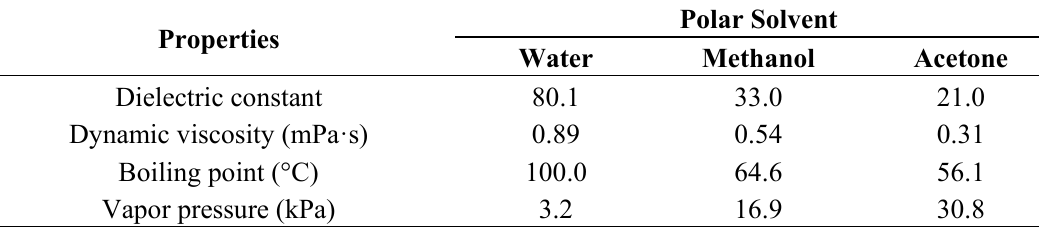
Table 3. Physical properties of polar solvents used in this study.